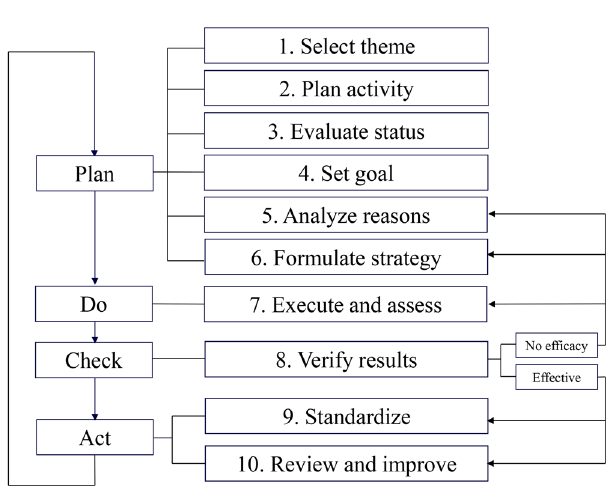
Table 4. Accuracy of intraocular lens power prediction before and after the quality control circle activity. QCC = Quality control circle, AL = Axial length. * The P value comes from comparing the results of PhacoOptics with those of the Haigis and SRK/T formulas after the QCC activity.